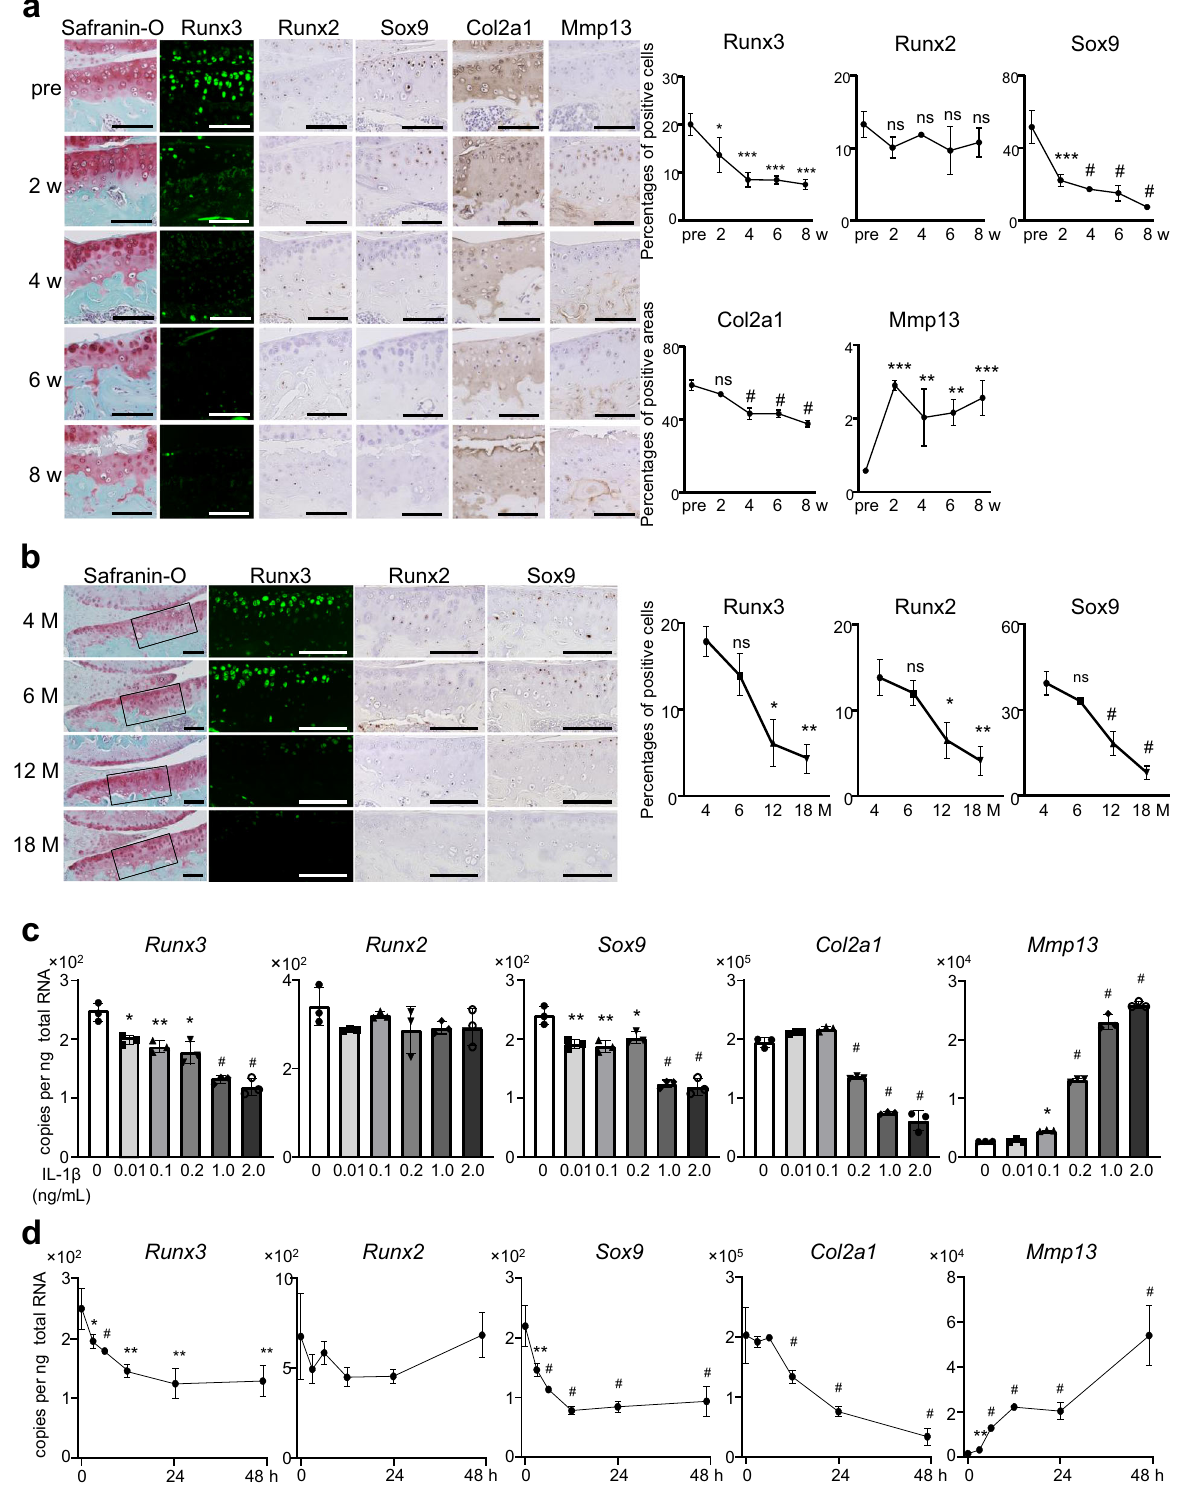
Fig. 1 | Expression of Runx3 and Runx2, during osteoarthritis (OA) develop- ment. a Immuno fl uorescence of chondrocyte markers during mouse OA devel- opmentfollowingresectionofthemedialmeniscusandmedialcollateralligament. Scale bars, 100 μ m. Percentages of immuno fl uorescence-positive cells or areas in the Safranin-O-positive areaareshown in rightpanels. b Immunohistochemistry of Runx3, Runx2, and Sox9 in knee joints of 4-, 6-, 12-, and 18-month-old mice. Scale bars, 100 μ m. c , d mRNA levels of marker genes in mouse primary chondrocytes